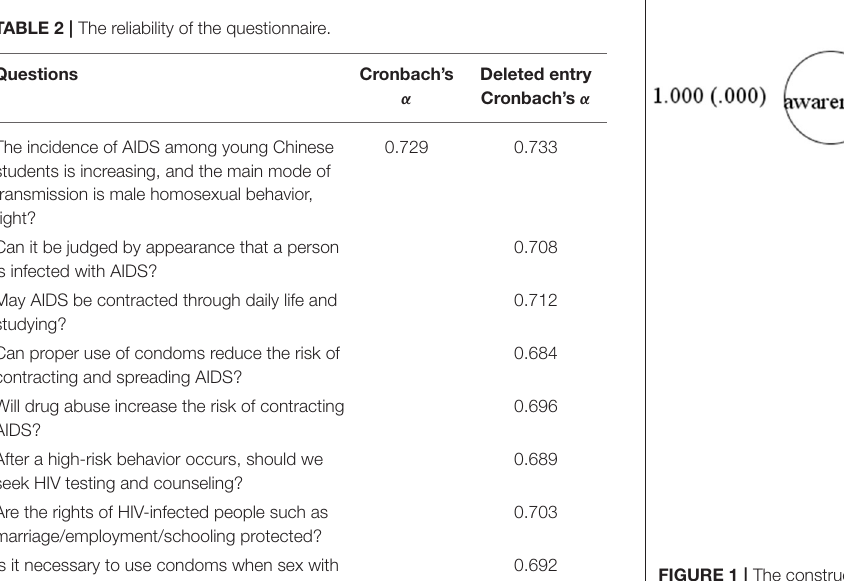
FIGURE 1 | The construct validity of the